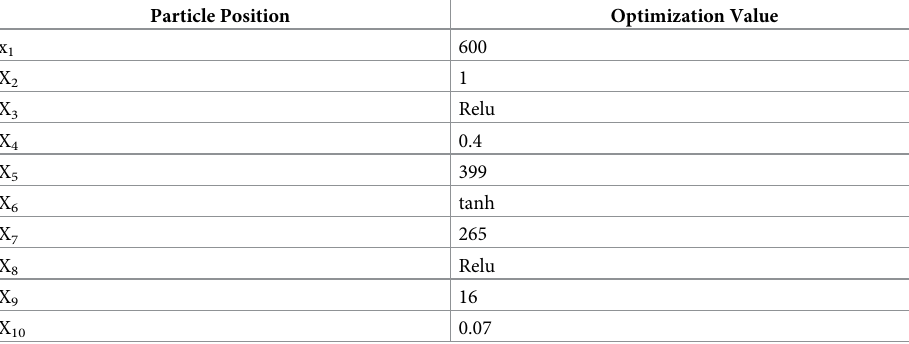
Table 5. CNN’s optimal hyperparameters utilizing the APSO-WOA-CNN algorithm. Particle Position Optimization Value